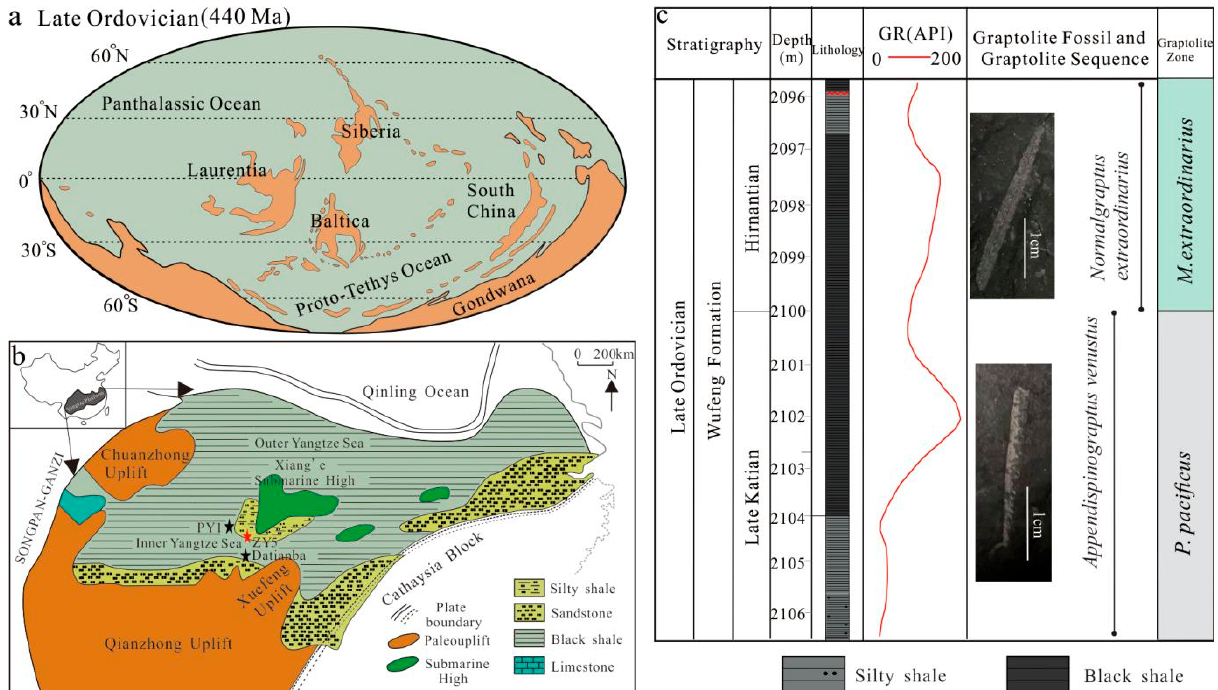
Figure 1. ( a ) Late Ordovician global paleogeography in South China (Modified after [2]); ( b ) Paleogeography of Yangtze Sea during the Late Ordovician (Modified after [1]); ( c ) Biostratigraphic division of Well ZY5 (Modified after [24]). Paraorthograptus pacificus = P. pacificus, M. extraordinarius = Metabolograptus extraordinarius.